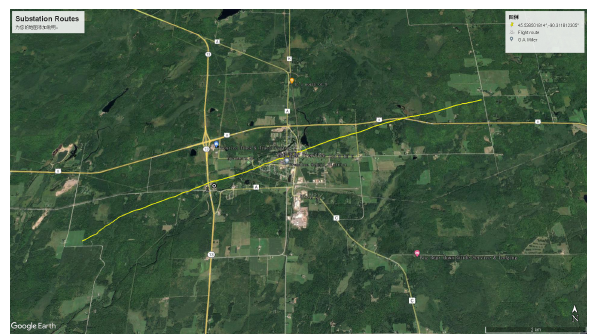
Figure 5. The flight trajectory